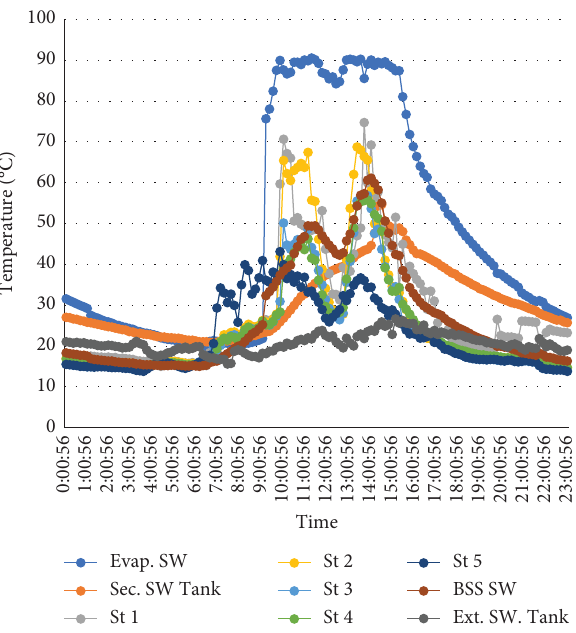
Figure 13: SW temperature in the condensing tower under high average conditions (23-Nov-2020).